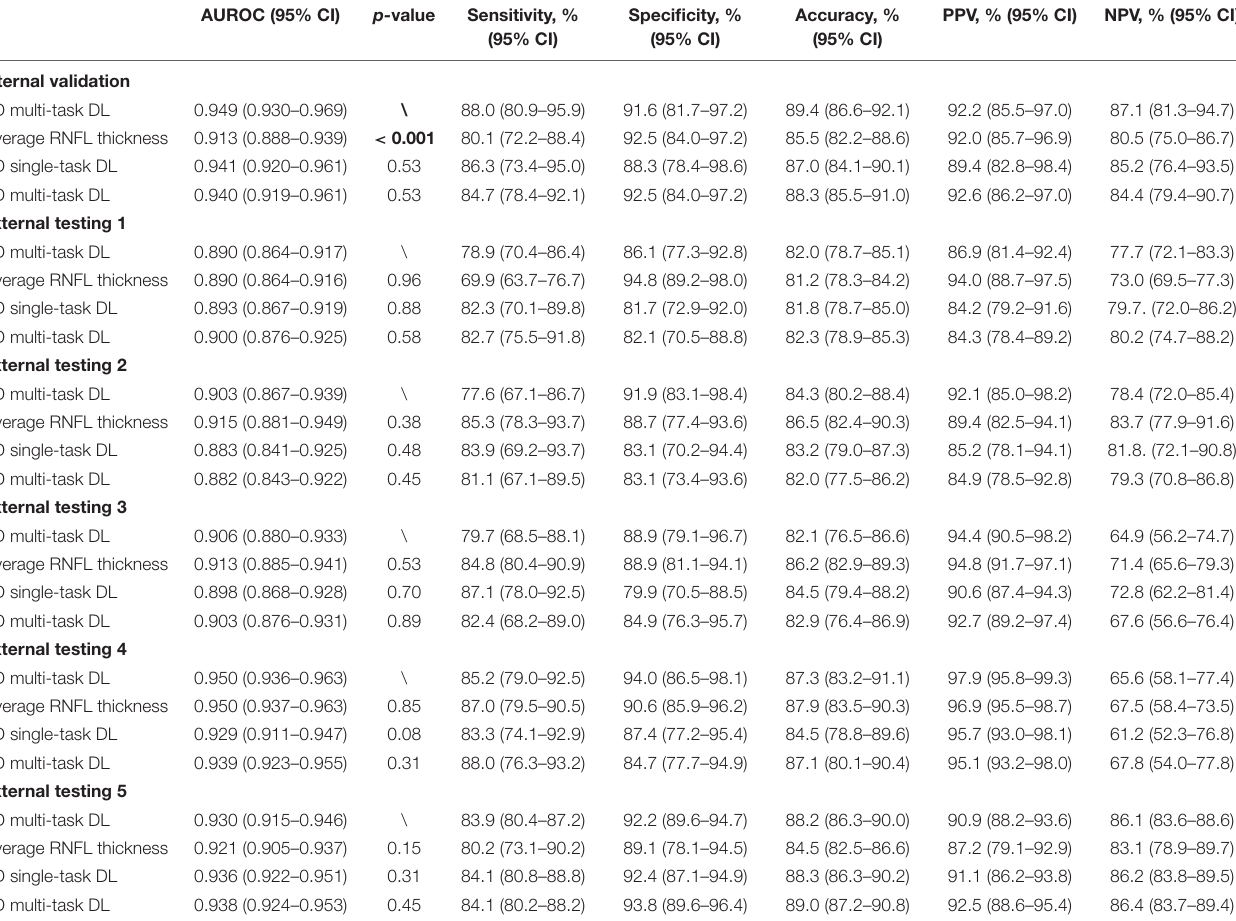
TABLE 2 | The discriminative performance of the multi-task 3D deep learning model for detecting glaucomatous optic neuropathy and the comparison to average retinal nerve fibre layer thickness, a single-task 3D deep learning model, and a multi-task 2D deep learning model in all datasets. AUROC (95% CI) p- value Sensitivity, % Specificity, % Accuracy, % NPV, % (95% (95% CI) (95% CI) (95% CI)